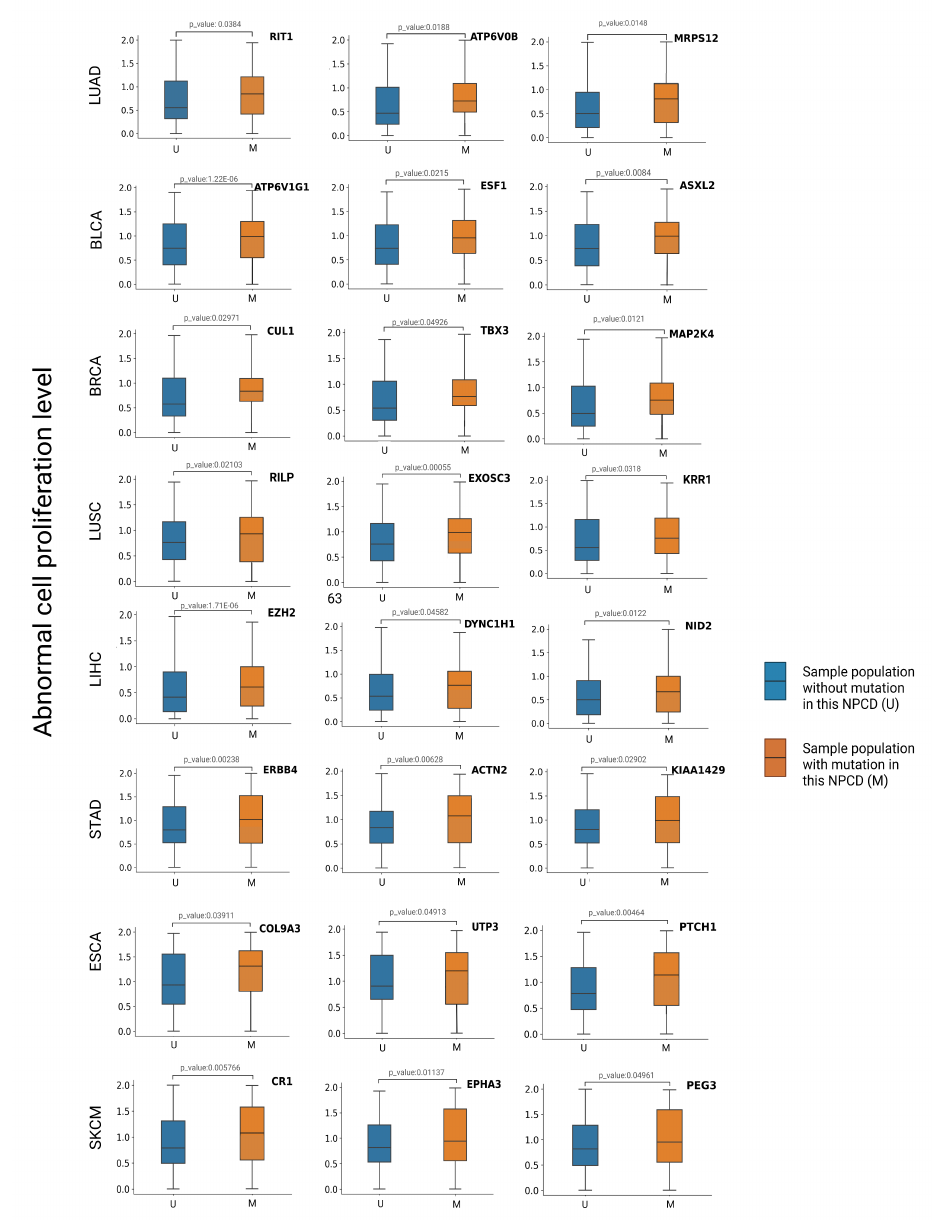
Figure 8. Box plots of abnormal cell proliferation level of CPRG. The box plots show the differences in the distribution of abnormal proliferation levels between samples with and without mutations in different tumor types. The blue and orange boxes represent the distribution of the U and M sample populations, respectively. The vertical axis is the abnormal cell proliferation level of each